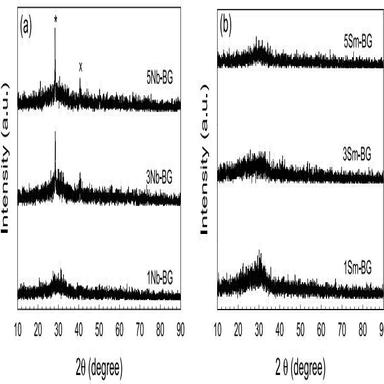
XRD patterns of the as-prepared (a) Nb5+, (b) Sm3+-substituted bioactive glass powders. (Nb2O5), ( X NbC).